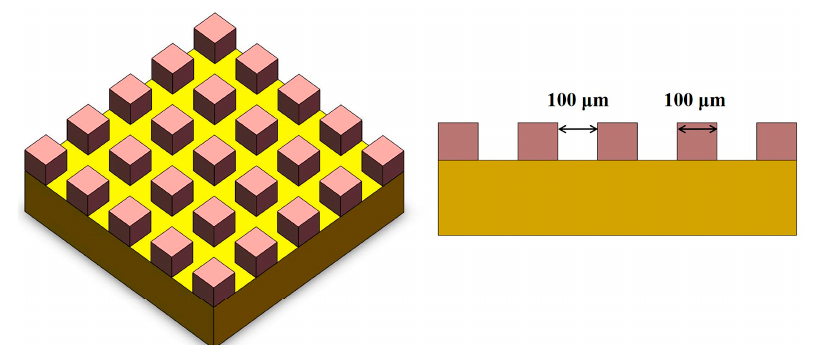
Figure 2. Schematic and dimension of the microarray structure.